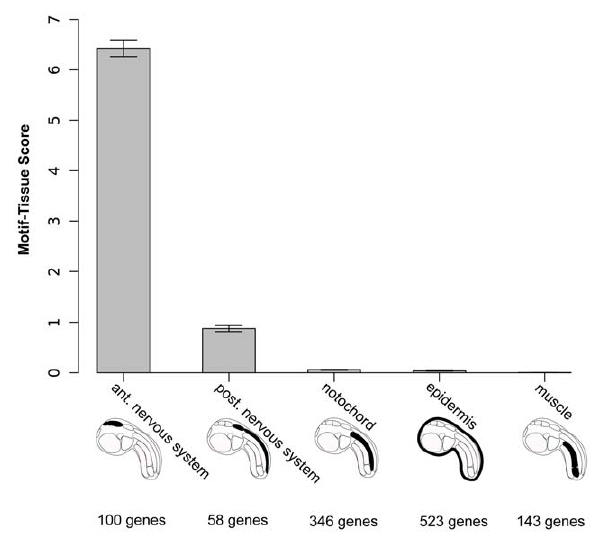
Figure 4. Motif-tissue scores for the motif 2 6 GATTA/125bp against genes expressed in various tissues. These territories are also visualized on schematic representation of an ascidian tailbud embryo. The number of genes is indicated for each category. To illustrate that changes in gene annotation are very unlikely to affect the overall ranking, we shuffled 10% of the gene-tissue assignments, repeated the procedure 100 times and plotted 95%-confidence intervals with error